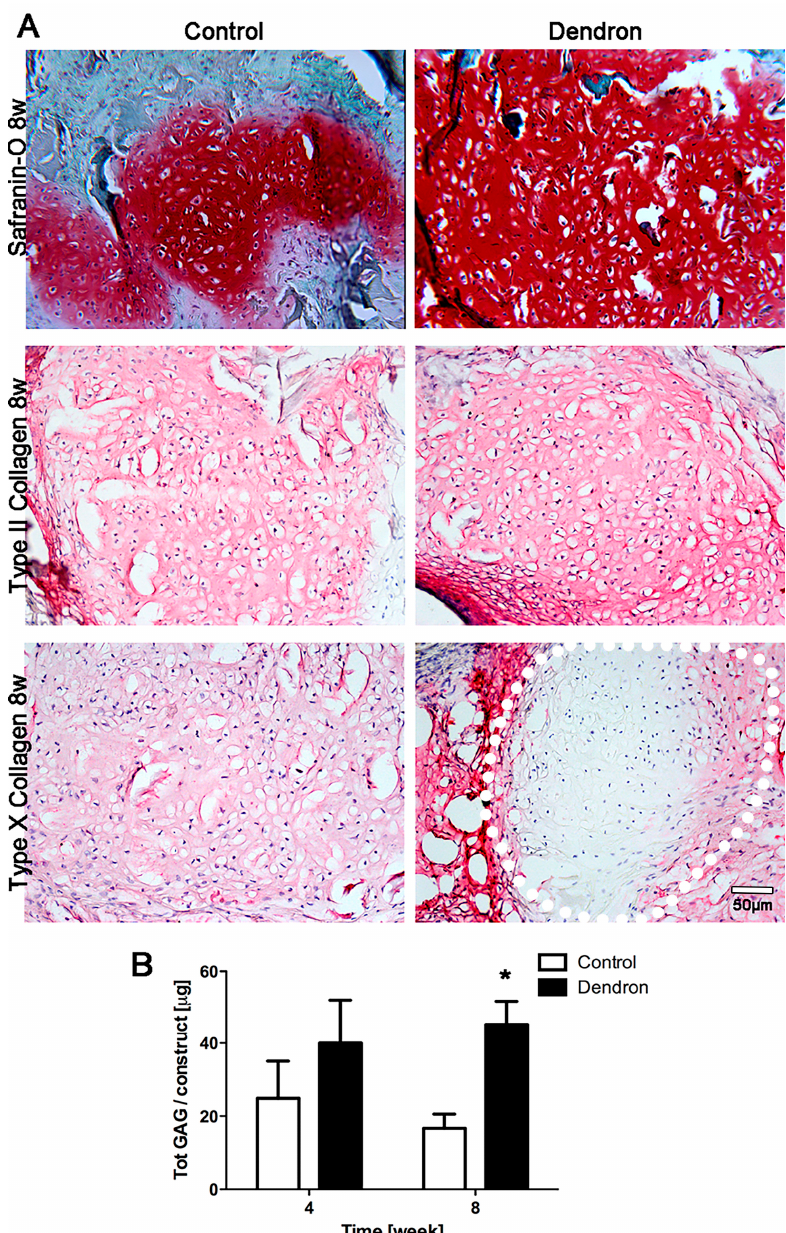
Figure 5. In vivo chondrogenesis of nasal chondrocytes-dendron-functionalized approach. ( A ) Safranin-O, types II and X collagen staining for control (naïve NC) and dendron-based constructs at 8 weeks in vivo. Dotted white line indicates the cartilaginous part of the dendron based implants. Scale bar = 50 µm. ( B ) Total GAG production in vivo at 4 and 8 weeks by control (naïve NC) and dendron-based constructs (1 donor, n = 5). * p < 0.01.